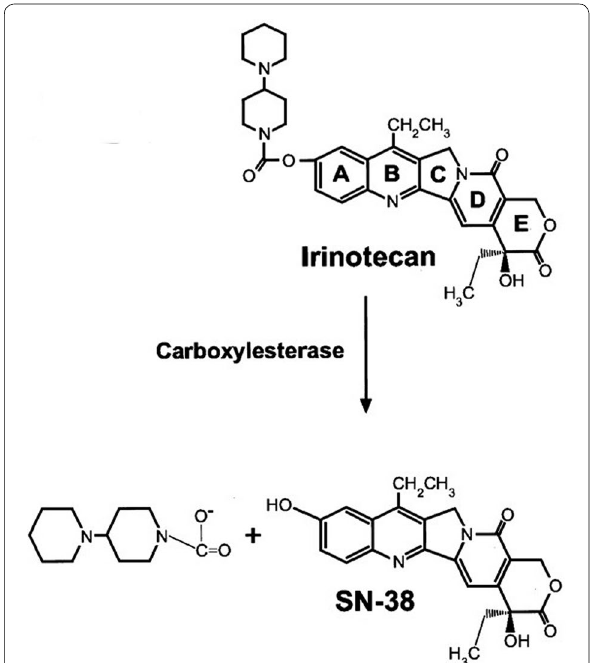
Fig. 5 Metabolic pathway of irinotecan activation into SN‑38 (Repro‑ duced with permission from